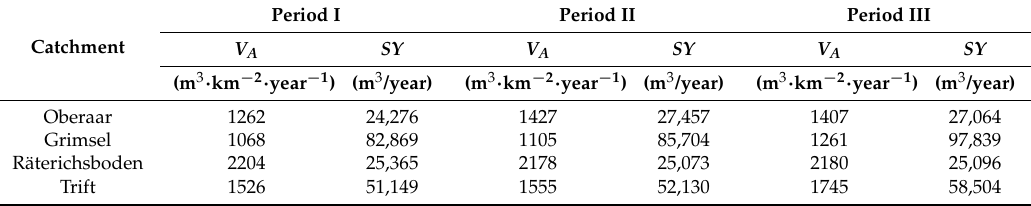
Table 2. Values of the sediment yield per unit area and of the absolute sediment yield ( V A and SY , respectively) in [m 3 /year] for each catchment and for each